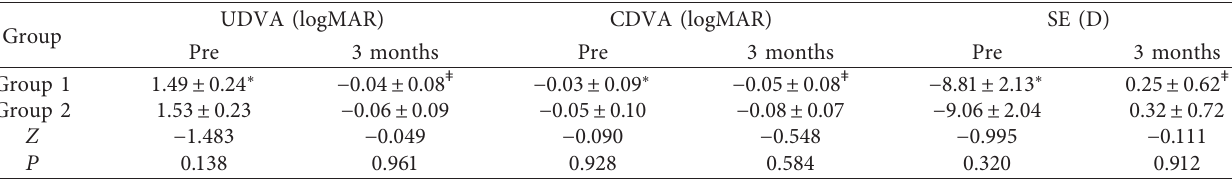
Table 1: Visual outcomes before and 3 months after surgery in both